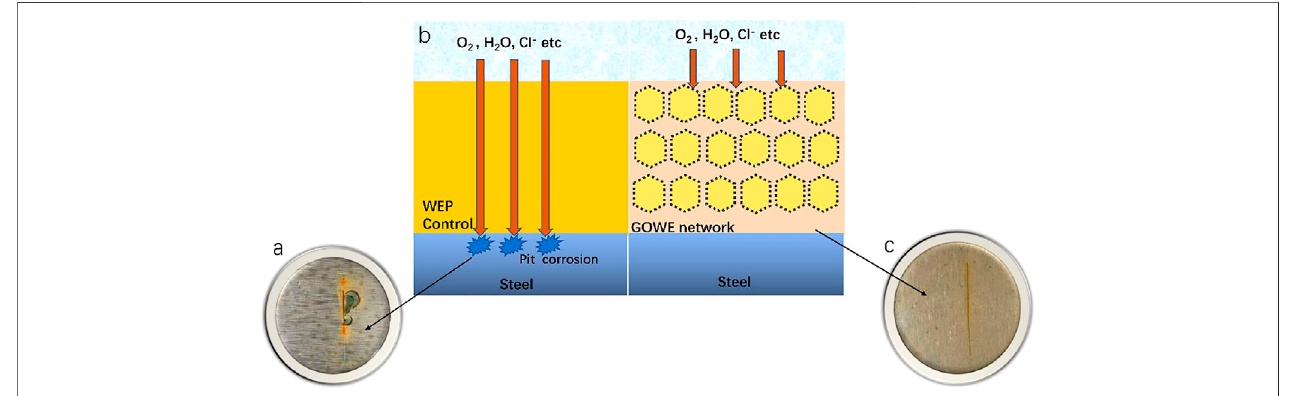
FIGURE11| SurfacemorphologyoftheWEPcoating(control,withoutGO)andGOWE-0.1(0.1 wt%GO)beforeandaftertheexposurein8 wt%NaClsolution. (A) WEP coating 120 h; (C) GOWE-0.1 coating, 120 h; (B) schematic diagrams of the anticorrosive mechanism of the WEP coating and the GOWE coating.